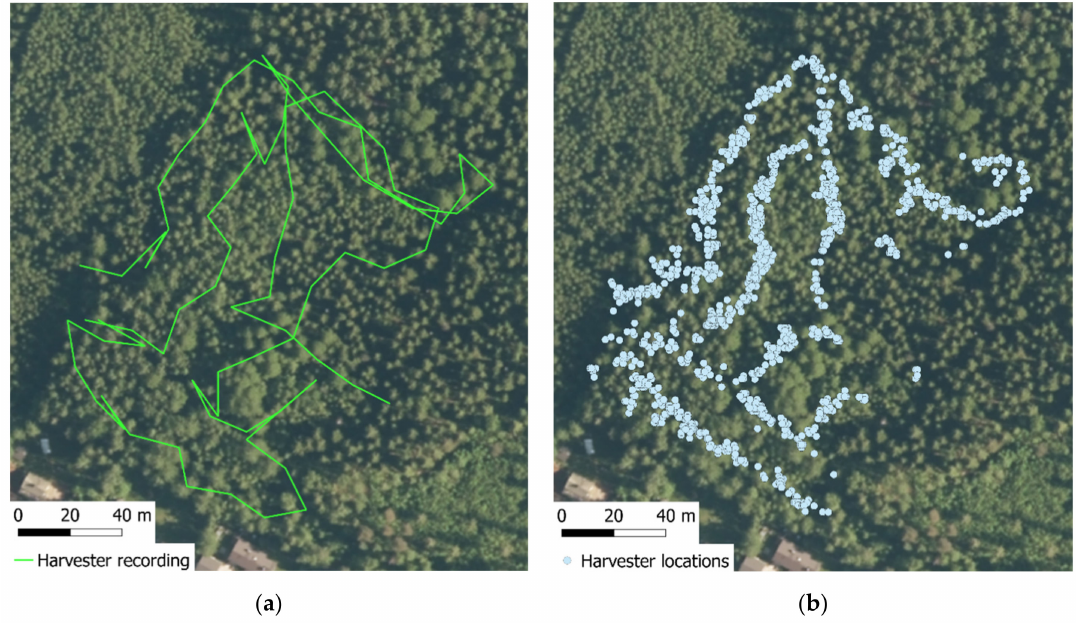
Figure 1. An example of a harvester route in a thinning. ( a ) The route recorded by harvester’s recording function.; ( b ) the harvester locations stored for each felled stem. Aerial image © National Land Survey of